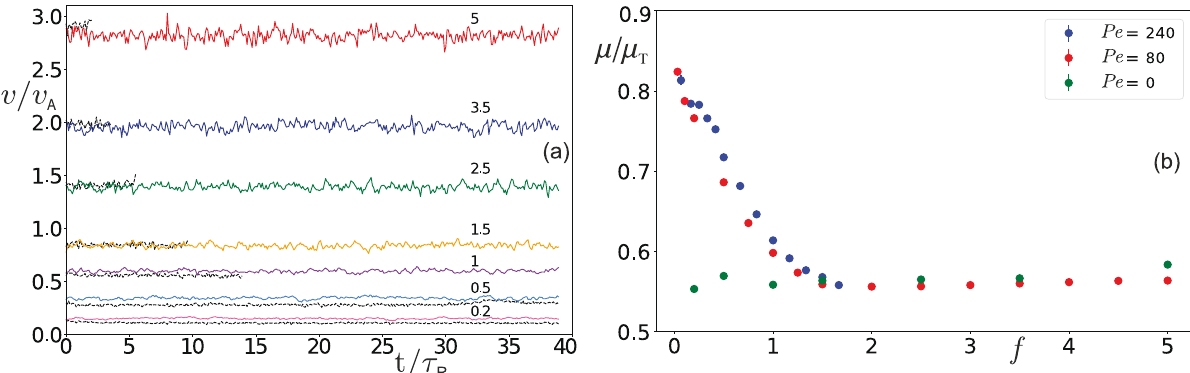
Figure 2. ( a ) The time fluctuations of the tracer speed v obtained by averaging over 100 independent simulation runs; v is measured in units of active disk speed v A and time t in units of active disk reorientation 0.2, 0.5, 1, 1.5, 2.5, 3.5, 5 two sets of lines are displayed: the time τ R . For each value of the driving force f = 80 , while the neighboring dashed black colored solid lines correspond to the tracer in an active bath with Pe = 0 . ( b ) Effective mobility µ of the tracer measured in units of bare lines represent the case of a passive bath, Pe = 0, 80, 240 . Note, to rescale mobility µ T as a function of force f for three different baths described by Pe =